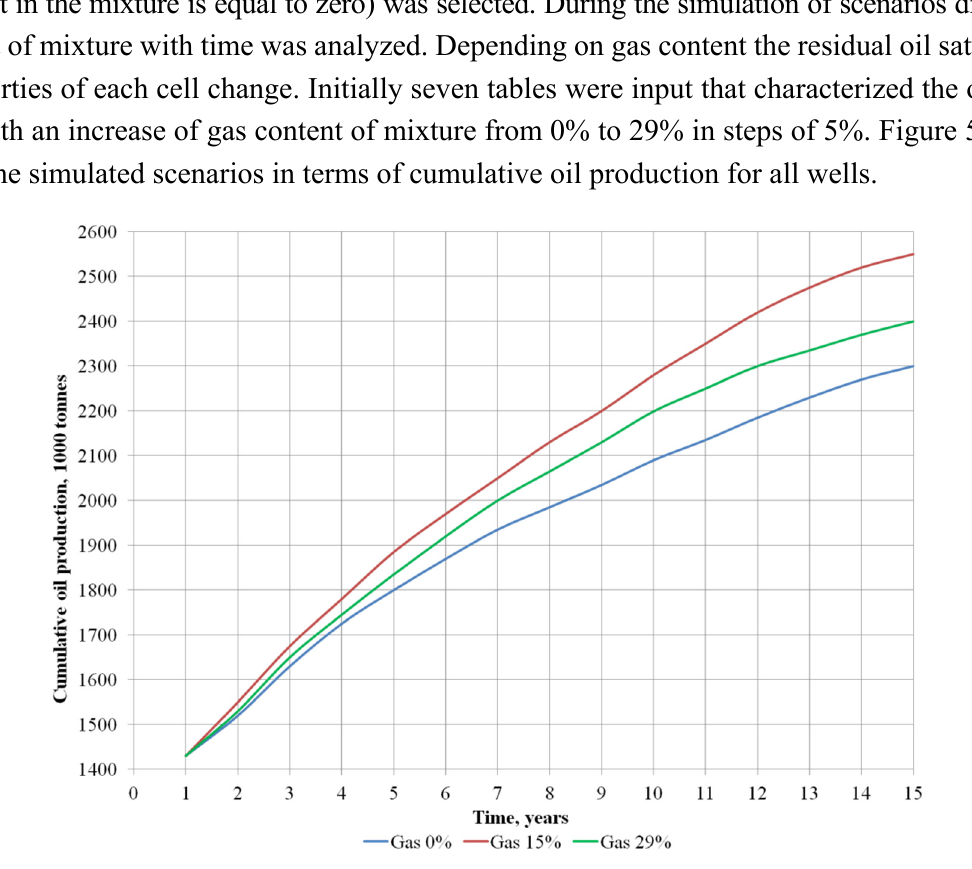
Figure 5. Results of calculation of cumulative oil production when gas mixtures are